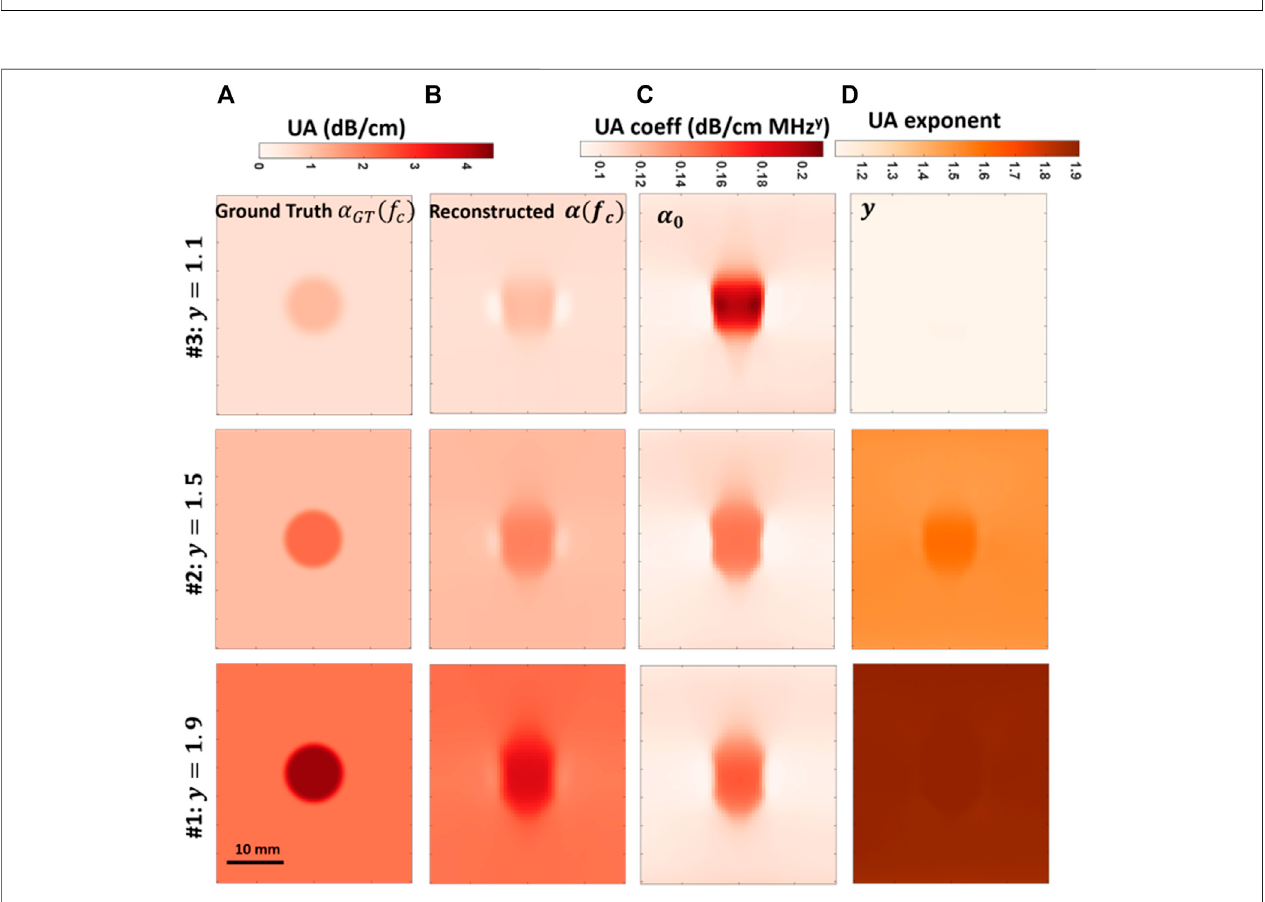
FIGURE 6 | Comparison of frequency-dependent UA imaging for simulations varying the power-law dependence parameter y = {1.1, 1.5, 1.9}, with columns from left to right (A-D) : ground-truth UA maps at center frequency 5 MHz; reconstructed UA maps at the center frequency; reconstructed α 0 maps; reconstructed y maps.